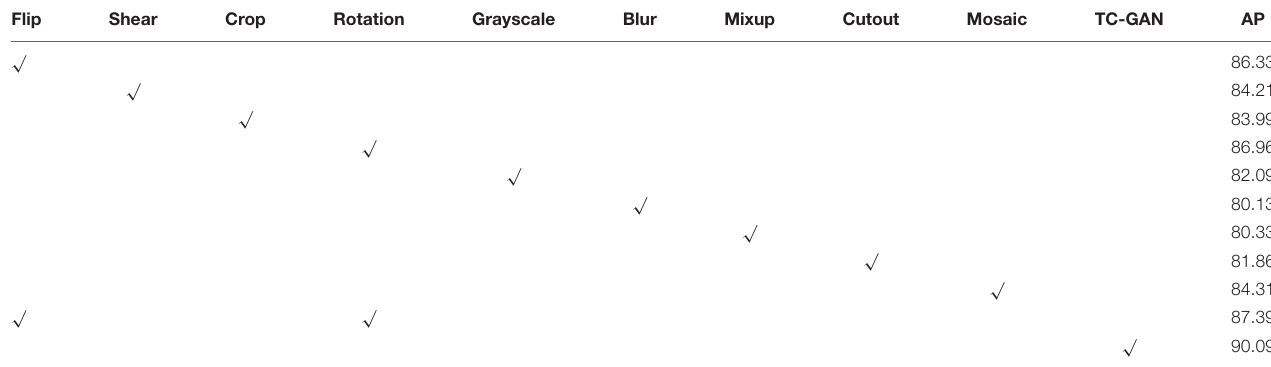
TABLE 3 | Performance comparison of different data enhancement